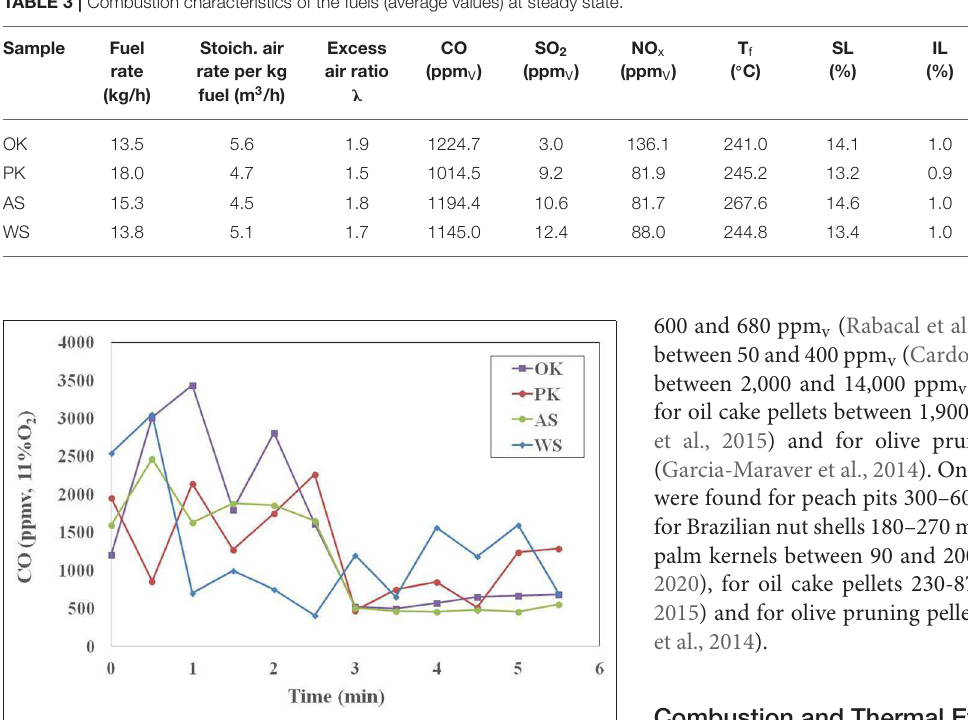
FIGURE 3 | CO concentration in flue gases for raw fuels at steady